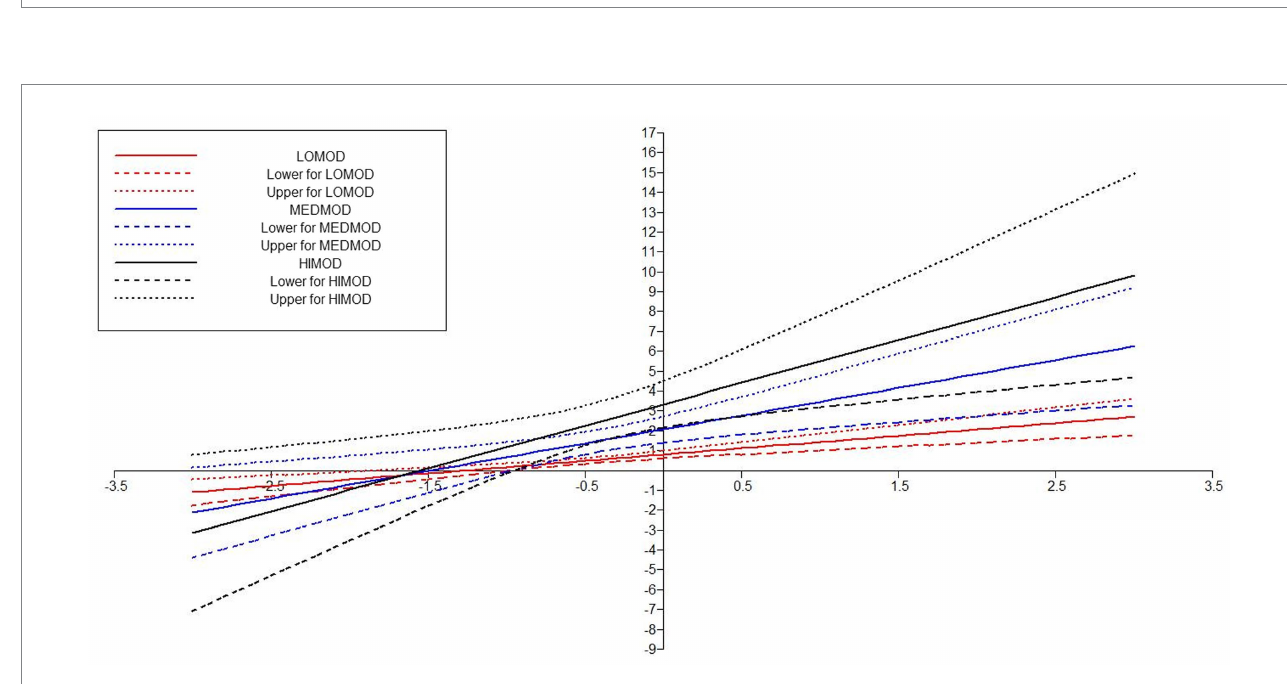
FIGURE 6 Interaction plot showing the moderating effect TESOL amplified communication apprehension on the relationship of formal education—entrepreneurial